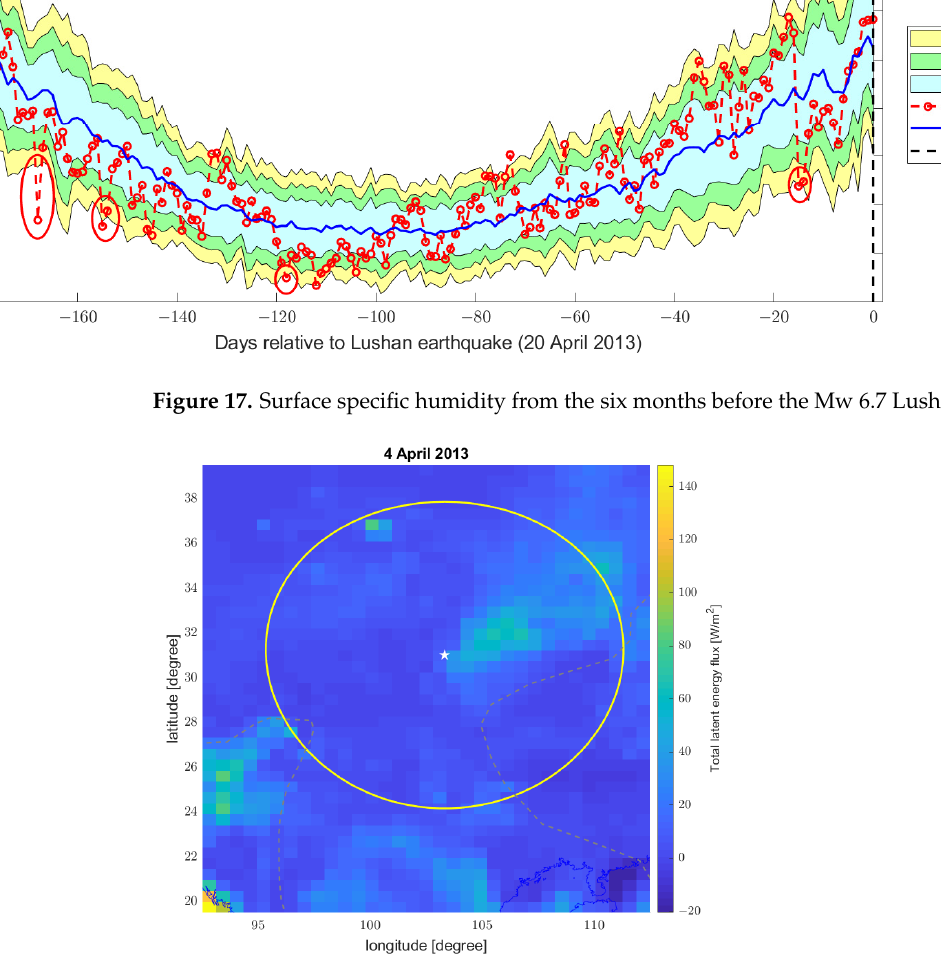
Figure 18. Map of the total latent energy flux on 4 April 2013. The white star indicates the epicenter of Mw 6.7 Lushan 2013